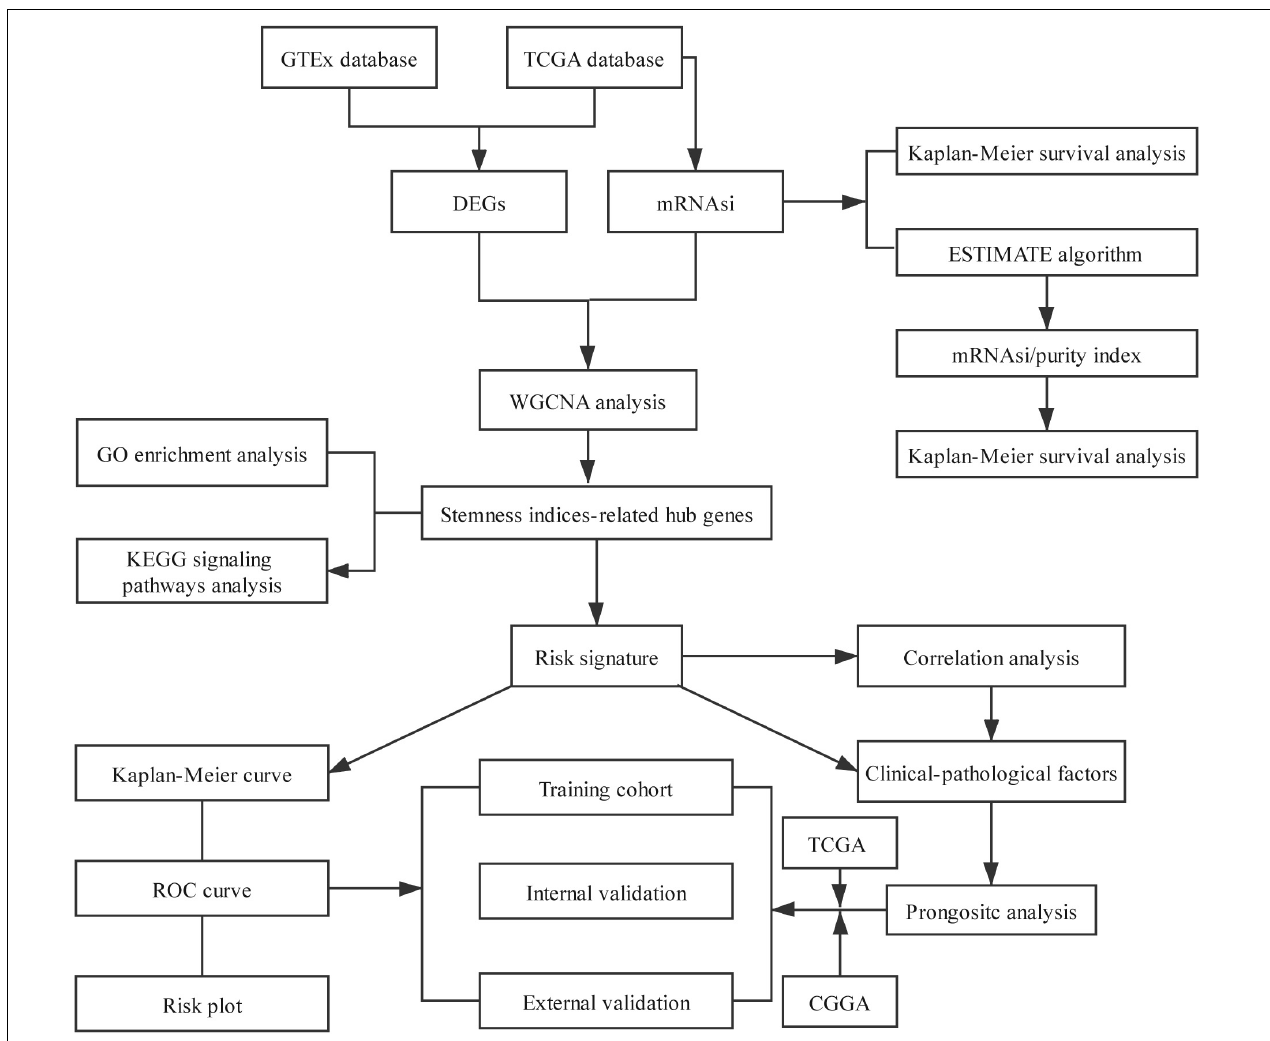
FIGURE 1 | Flowchart presenting the process of establishing the stemness index-related